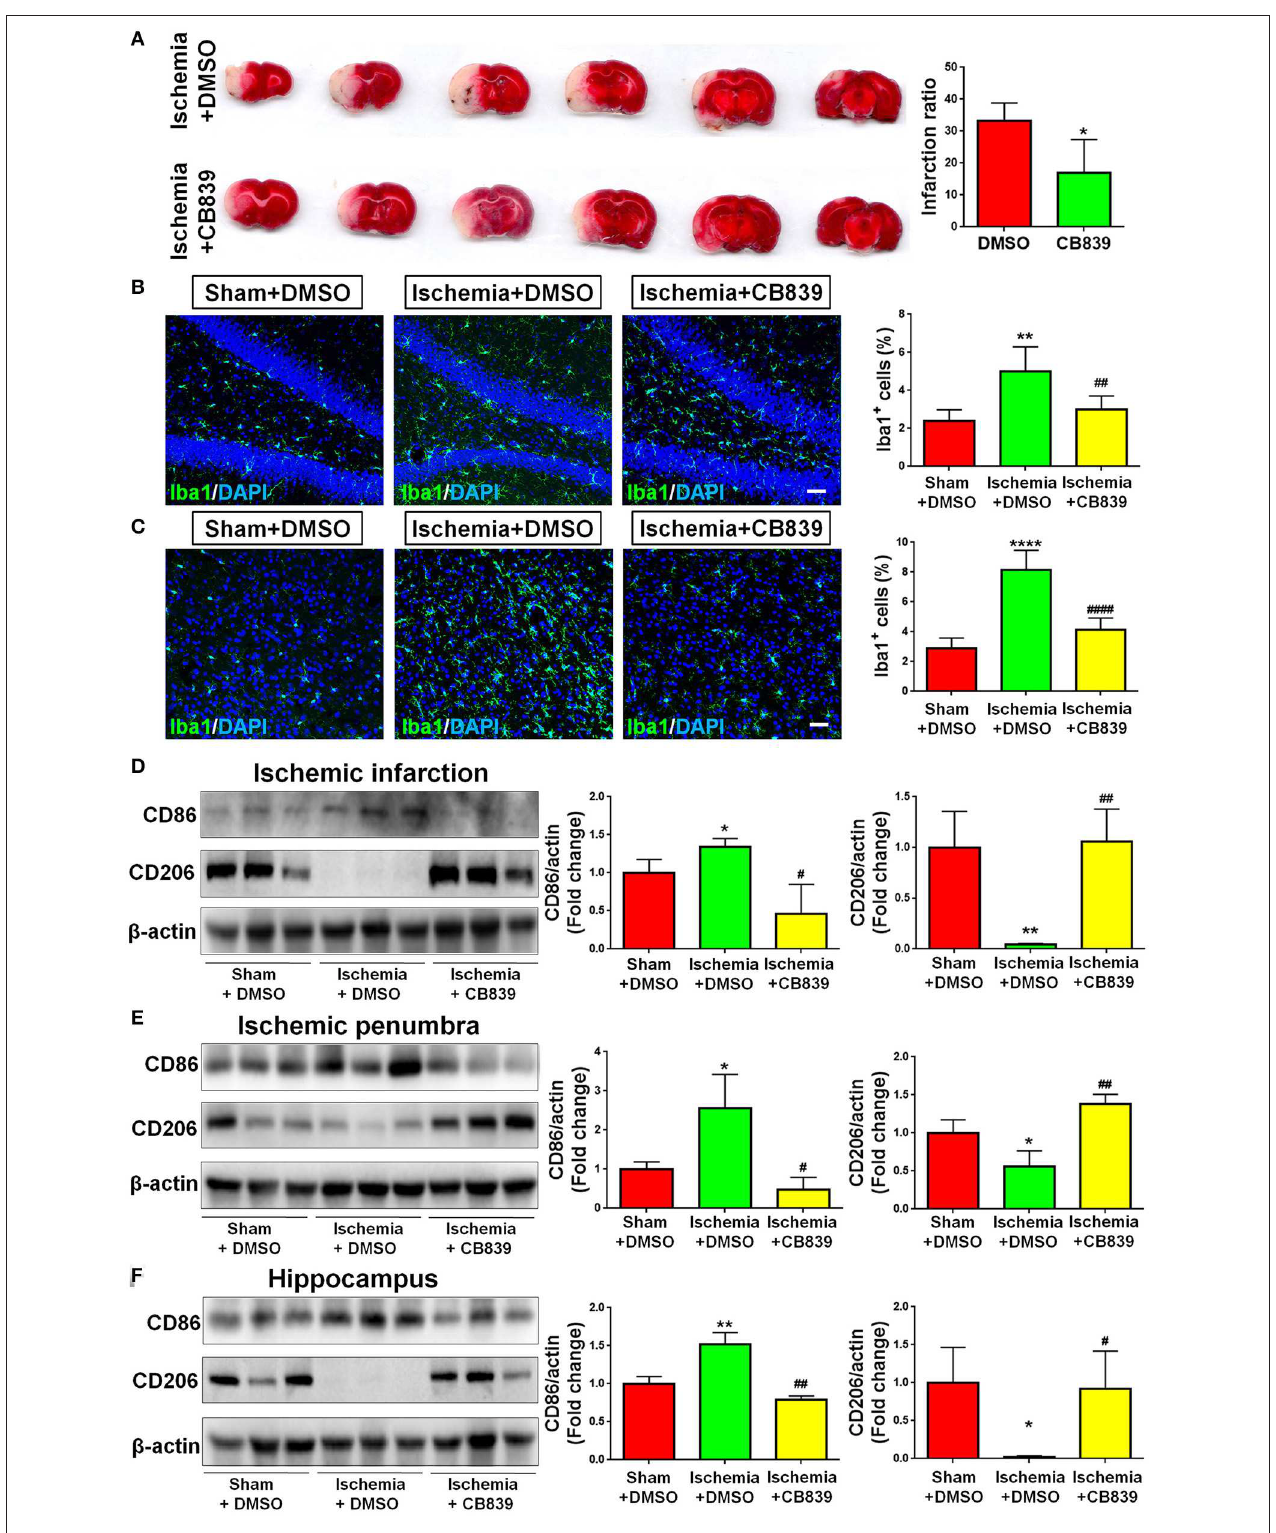
FIGURE 3 | GLS1 inhibition by CB839 alleviates neuroinflammation. (A) TTC staining of rat brain serial coronal slices in sham, ischemia, and ischemia with CB839 treatment groups. Infarction volume is given on the right panel. (B,C) Focal cerebral ischemic brains treat with or without CB839 and their sham controls